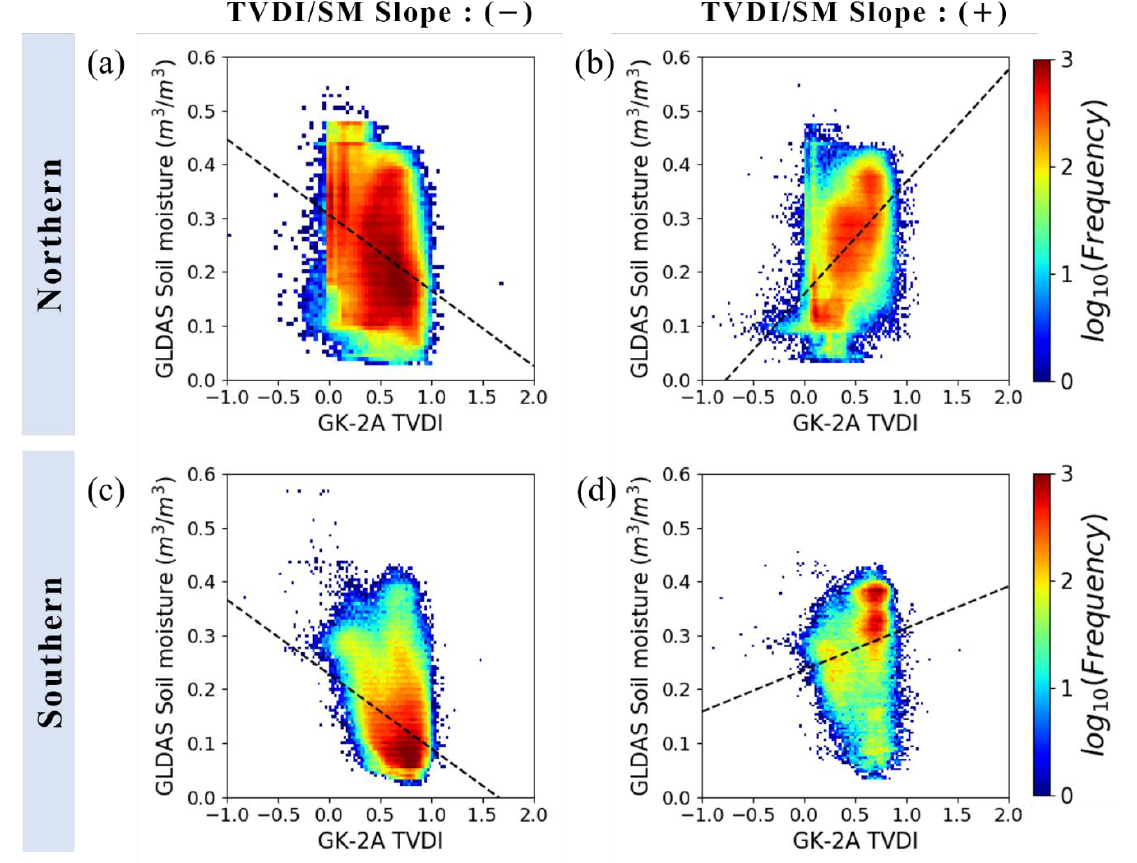
Figure 13. Scatterplots between GK-2A TVDI and GLDAS SM from August 2019 to July 2020 with ( a ) negative and ( b ) positive slopes in the northern hemisphere, and ( c ) negative and ( d ) positive slopes in the southern hemisphere.